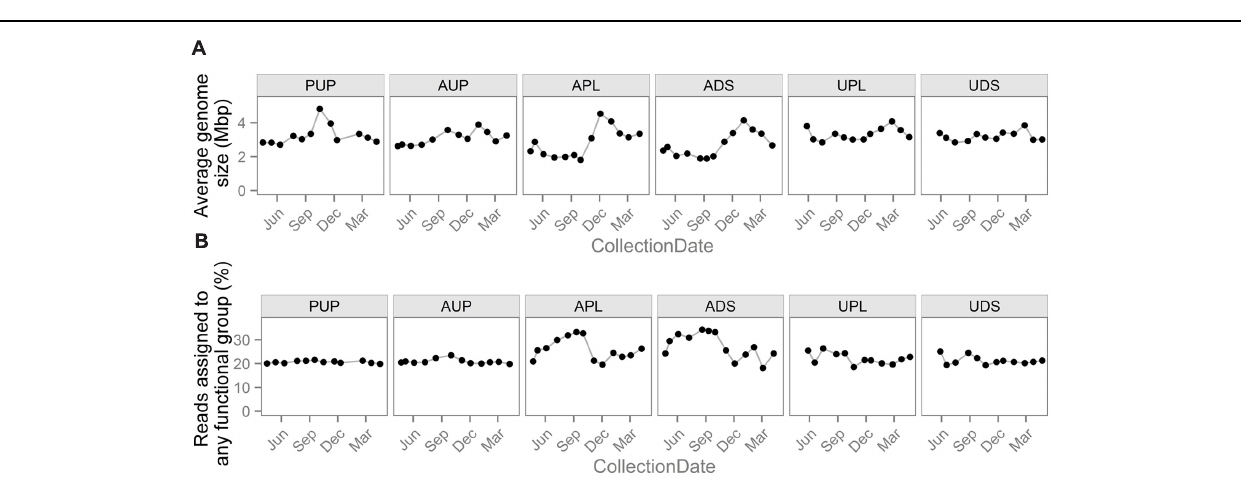
FIGURE 4 | Normalization factors used in different strategies to enable comparisons of gene group abundances between samples. Notable differences exist among sites and over time in both (A) average genome size and (B) the percentage of reads assigned to any gene functional group. This variability demonstrates how normalization schemes using these values can have a drastic effect on downstream